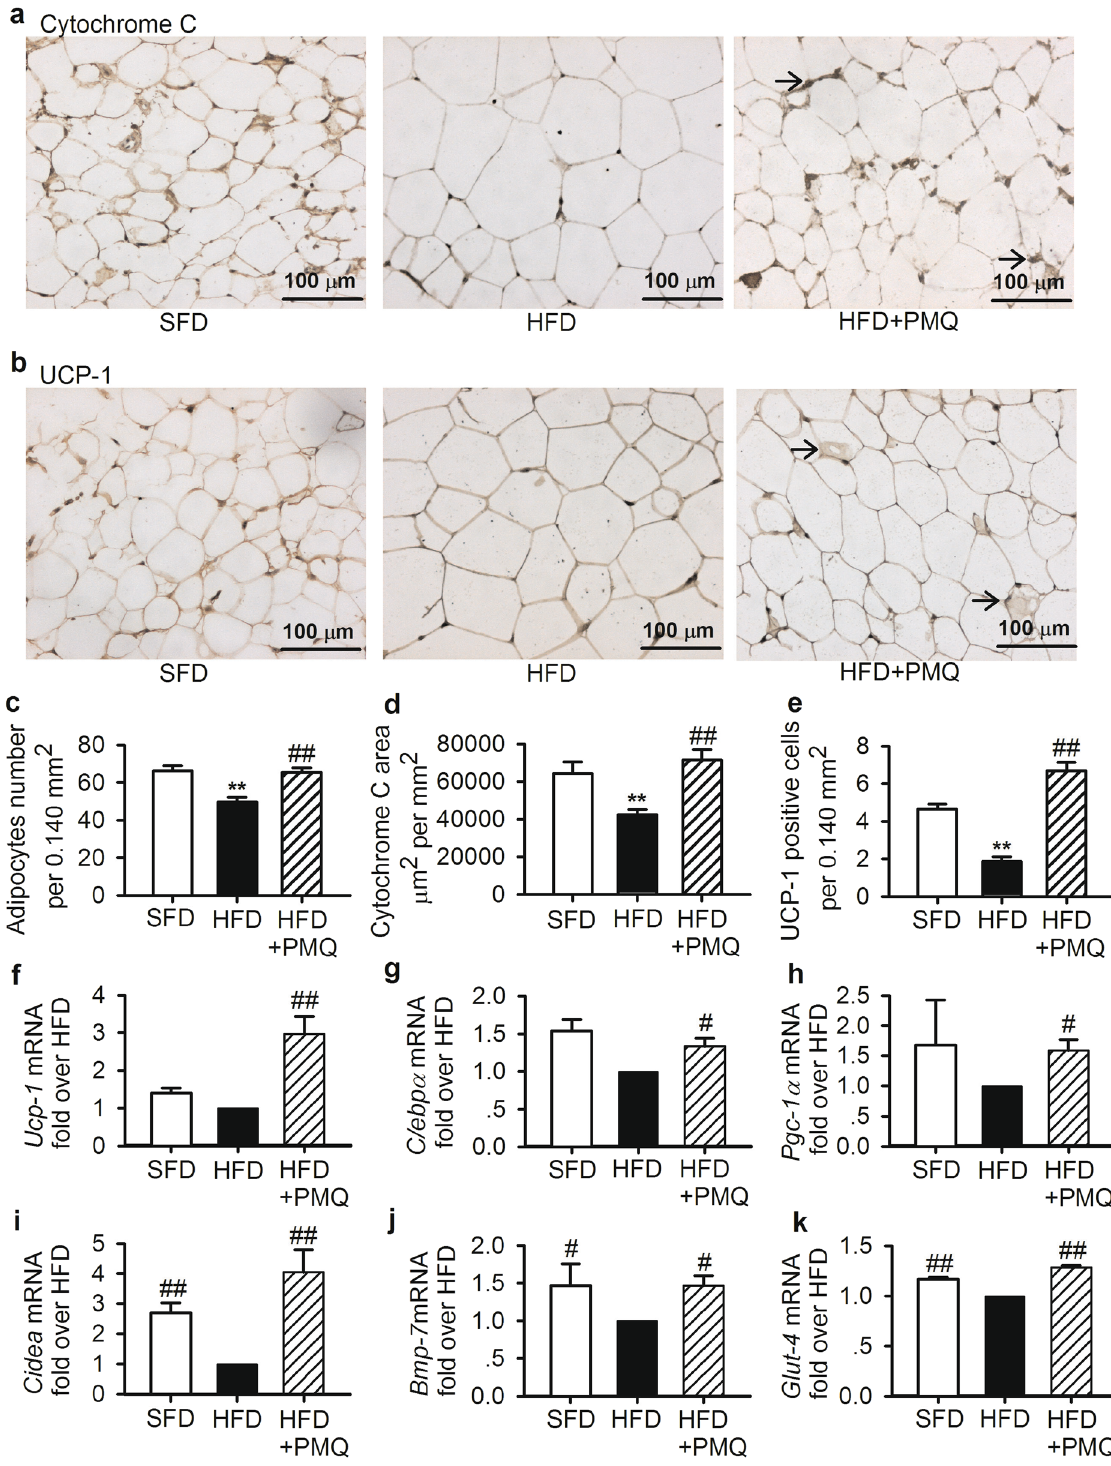
Figure 6. PMQ induced morphological and molecular changes in adipose tissue in HFD mice. Epididymal adipose tissues from HFD mice treated with the indicated agents (n = 10 experiments) were stained with mitochondrial markers. ( a , b ) Representative images of cytochrome C and UCP-1 staining. The arrows indicate cytochrome C-enriched or UCP1-enriched brown adipocytes. ( c ) Morphometric analysis of adipocyte size, which was determined based on the average numbers of cells in the acquired images (total area = 0.14 mm 2 ). ( d ) Morphometric analysis of cytochrome C-stained areas. ( e ) Average numbers of UCP1-positive adipocytes in the acquired images (total area = 0.14 mm 2 ). ( f–k ) qPCR analysis of the mRNA levels of the following brown fat- selective genes in epididymal fat tissue: Ucp-1 , C/ebp α , Pgc-1 α , Cidea , Bmp7 , and Glut-4 ( n = 5 experiments). The data are expressed as the mean ± SEM. ** p < 0.01 vs SFD; # p < 0.05 , ## p < 0.01 vs